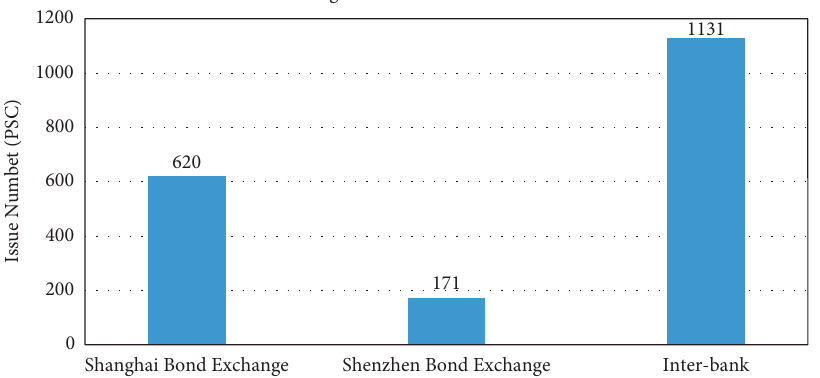
Figure 2: Listing Location of China’s Green Bonds (Data source: Wind, compiled by the author).